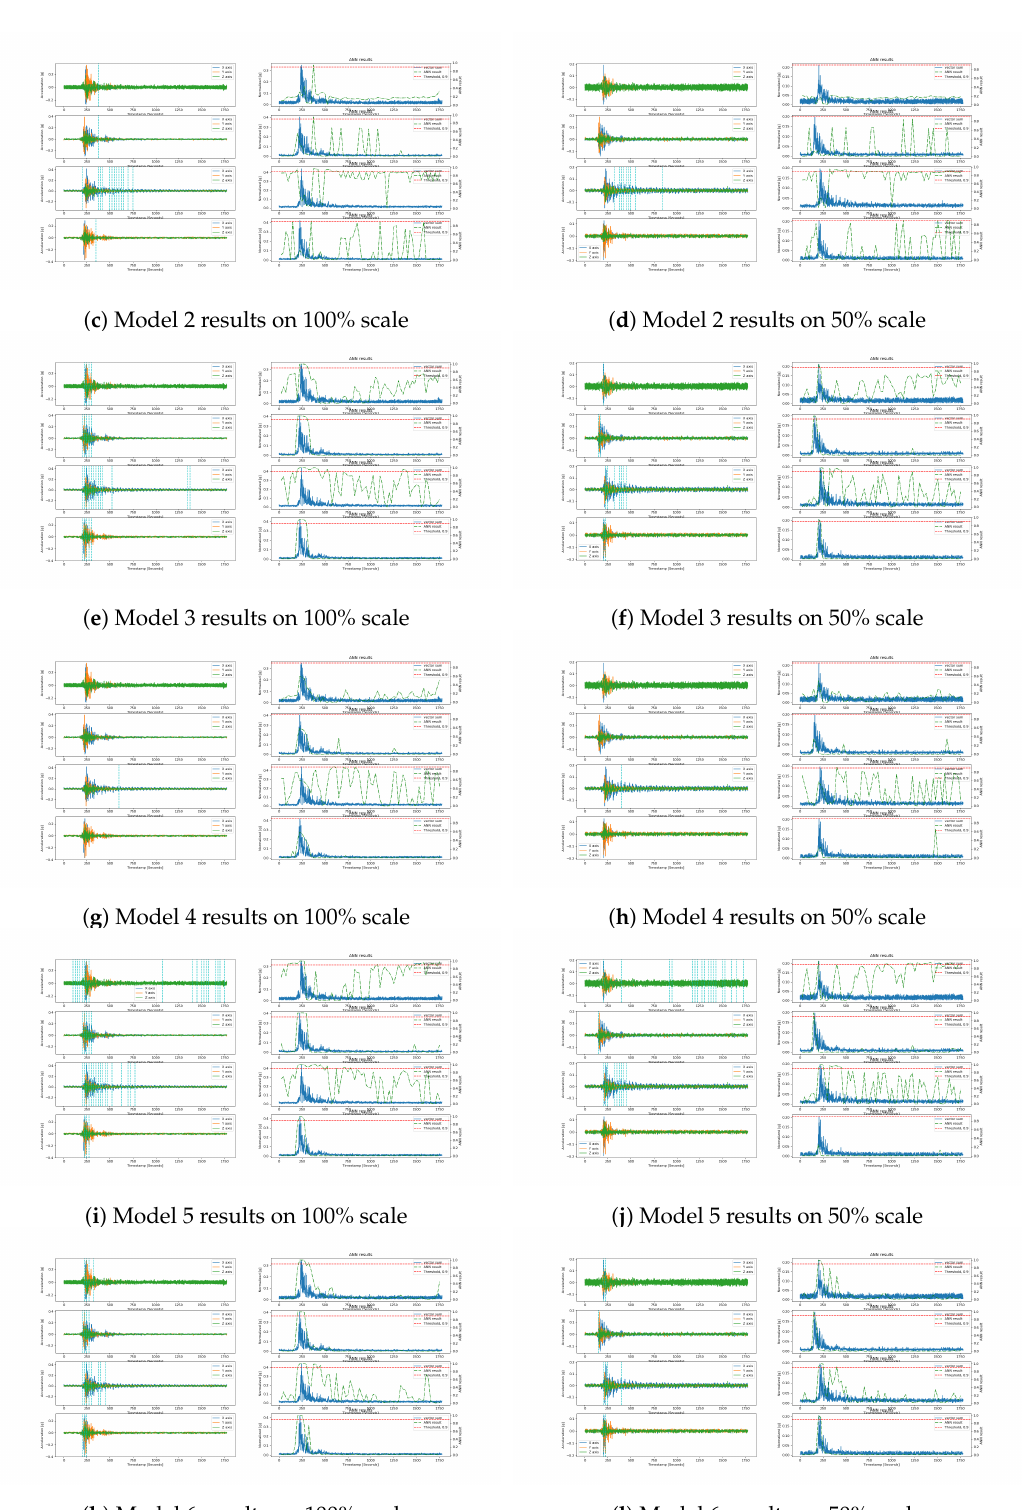
Figure 9. Models’ test results on the Pohang earthquake at a scale of 100% (left) and 50% (right); the results are ordered from top to bottom for each subfigure’s sensor, namely ADXL355, LIS3DHH, MMA8452, and